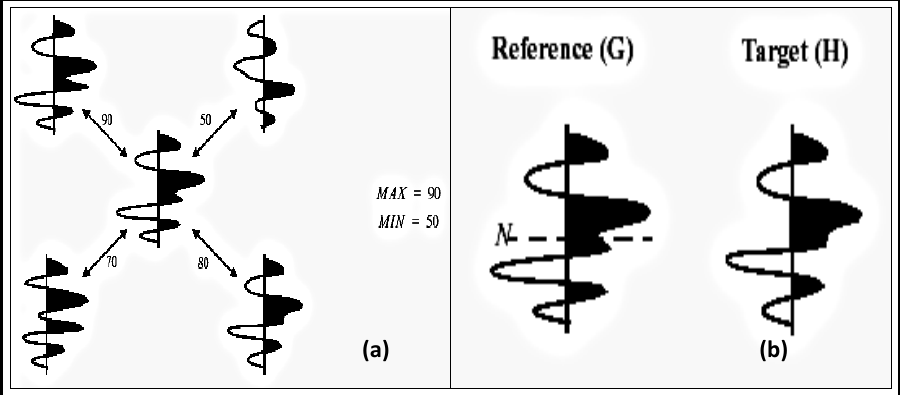
Figure 12. ( a ) Four-trace analysis patterns. ( b ) Performs Manhattan distance analysis for center trace to target trace, selected from the semblance scan